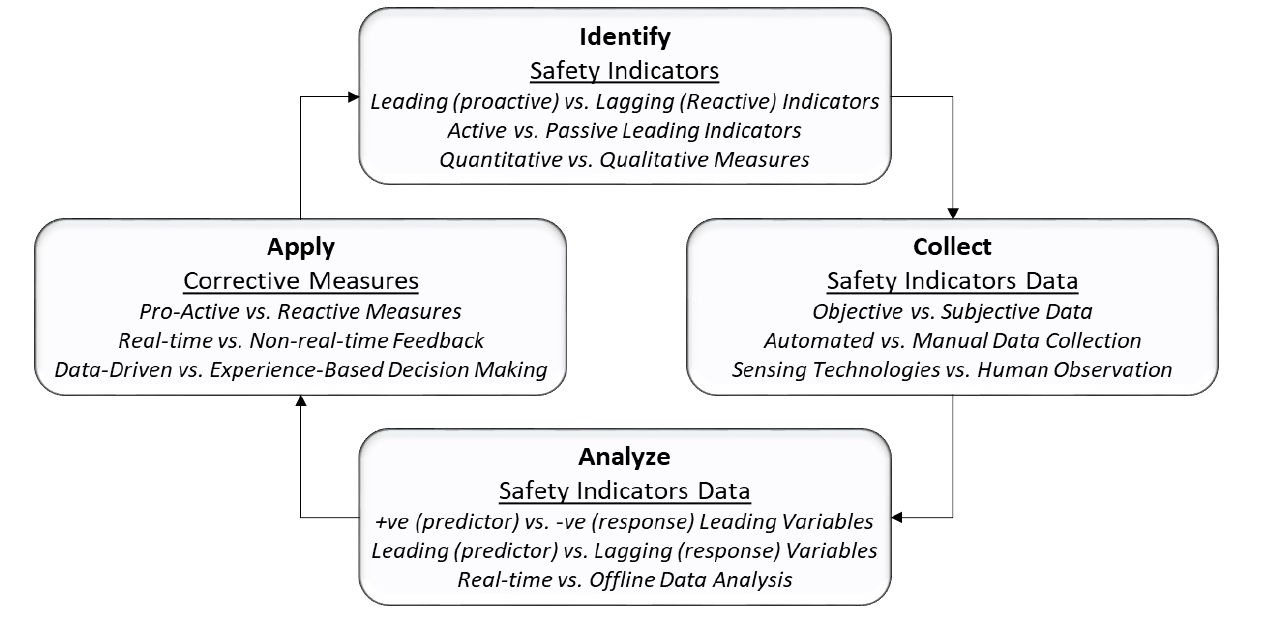
Figure 1. Framework for monitoring and measuring safety performance.